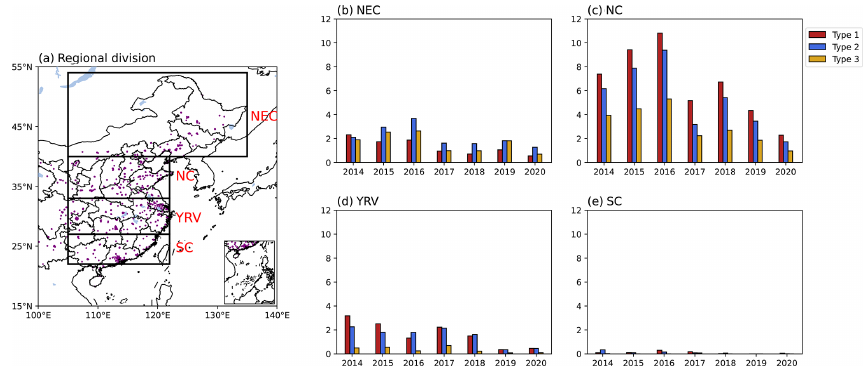
Figure 12. (a) The four subregions of EC. The purple dots are the stations. (b–e) Frequency of three types of cool season severe HD EC in NEC, NC, YRV, and SC.